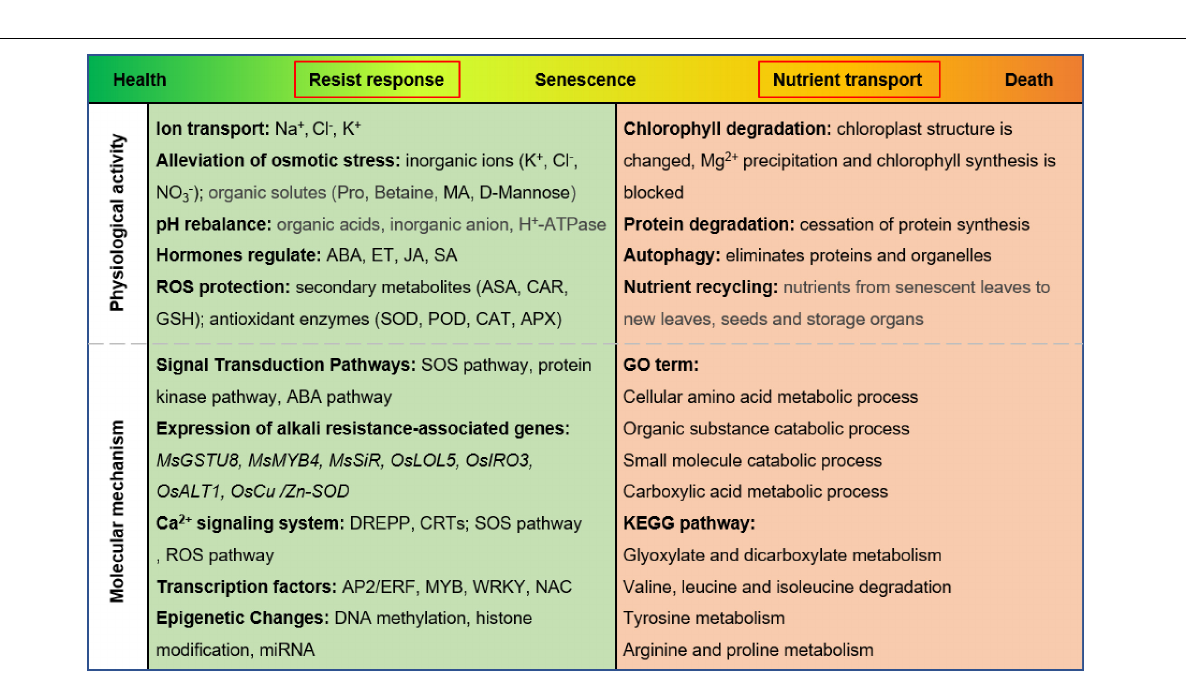
Frontiers in Plant Science |